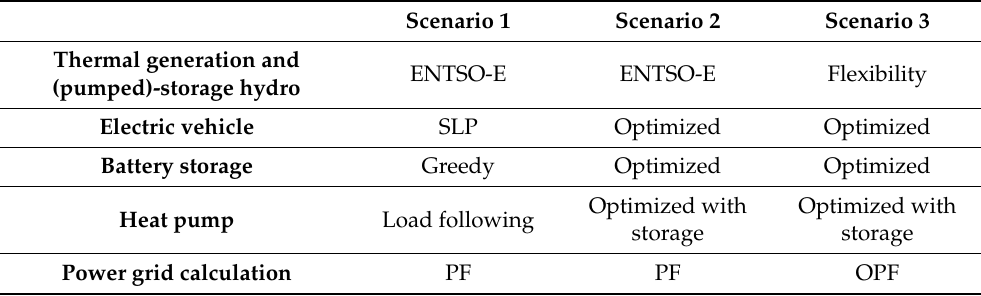
Table 4. Scenario